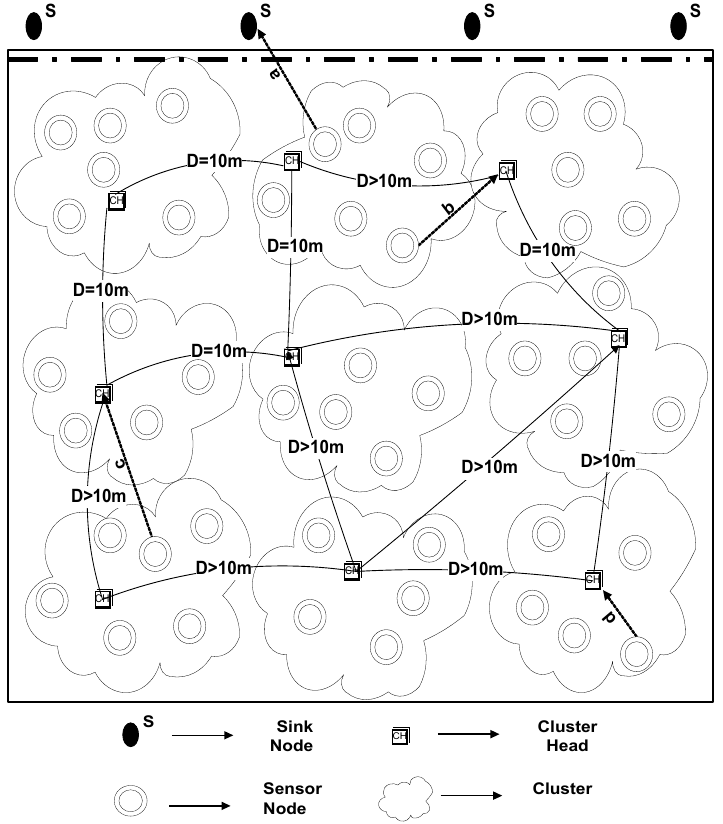
Figure 8. U-(ACH) 2 with Four Sinks at Water